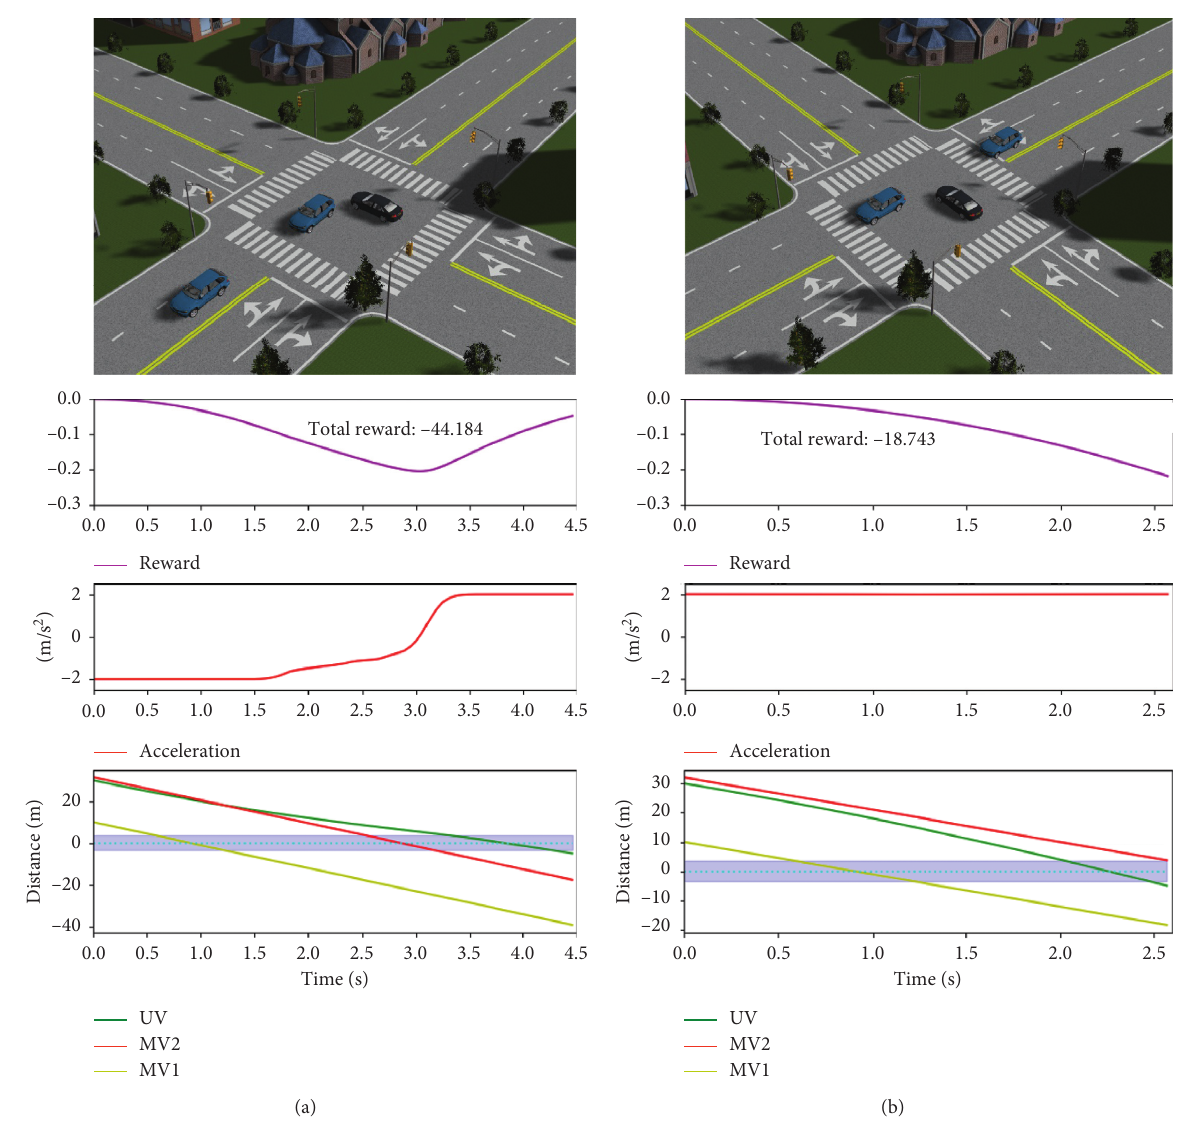
Figure 10: Comparison of the performance of the two algorithms. (a) NSGA-II. (b) DDPG.